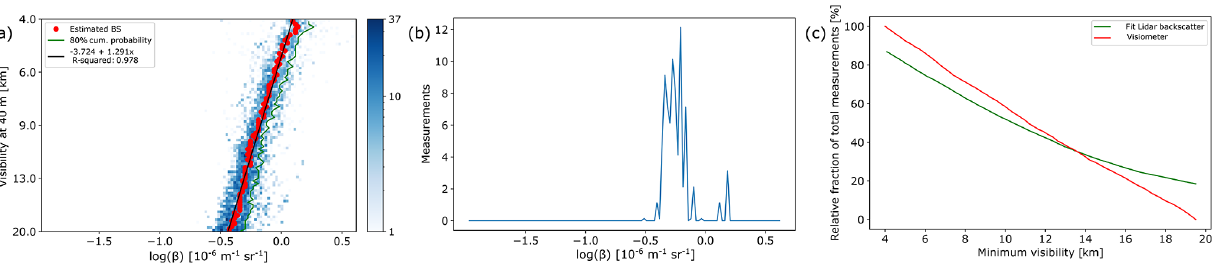
Figure 5. Visiometer readings versus lidar backscatter, for Pershore; 39m (2m)a.g.l. for lidar (visiometer). Data cover the full range from 1 January 2018 to 1 January 2020. (a) The 2D histogram. Overlain are the centroid backscatter values (red dots), 80% cumulative probability (green) for each visibility and the transfer function (black), to be read as log (V − 1 ) = − 3724 + 1291 x , where V is visibility, x = log (β) ; log depicts the decadic logarithm. (b) The 1D slice at a visibility of 12km. (c) Relative fraction of total measurement for a given visibility using the fitted BS values and the visiometer data